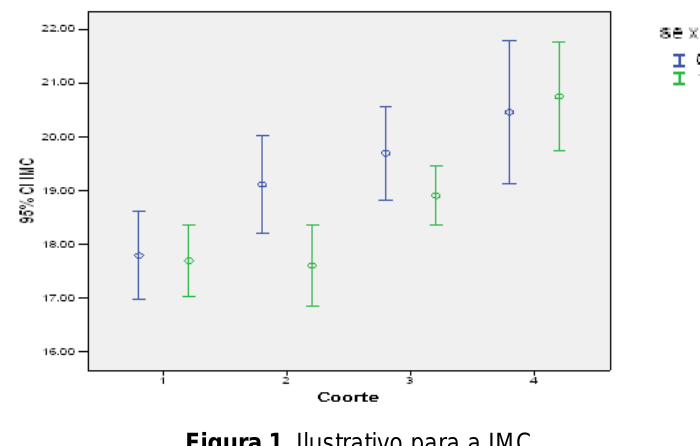
Figura 1. Ilustrativo para a IMC.